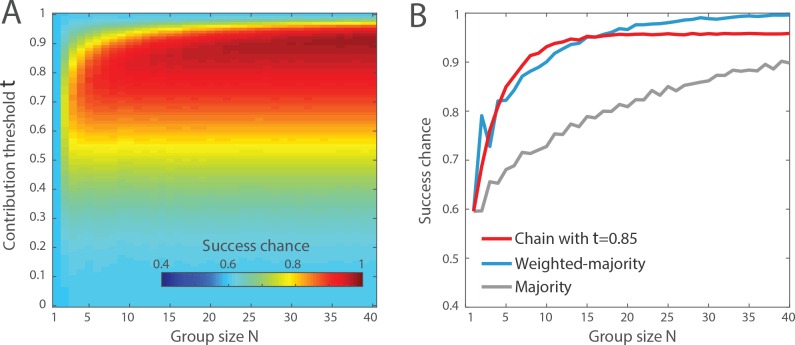
Impact of the group size N.(A) The color-coding indicates the probability of success of the chain method as a function of the group size N and the contribution threshold τ. The column of values at N = 10 corresponds to the red curve shown in Fig 3. (B) Comparison of the performance of the chain method with the contribution threshold set to τ = 0.85 (in red), the majority rule (in grey), and the weighted-majority rule (in blue). These results are computed assuming a proportion of correct answer q1 = 0.6 and the confidence distributions shown in Fig 1.